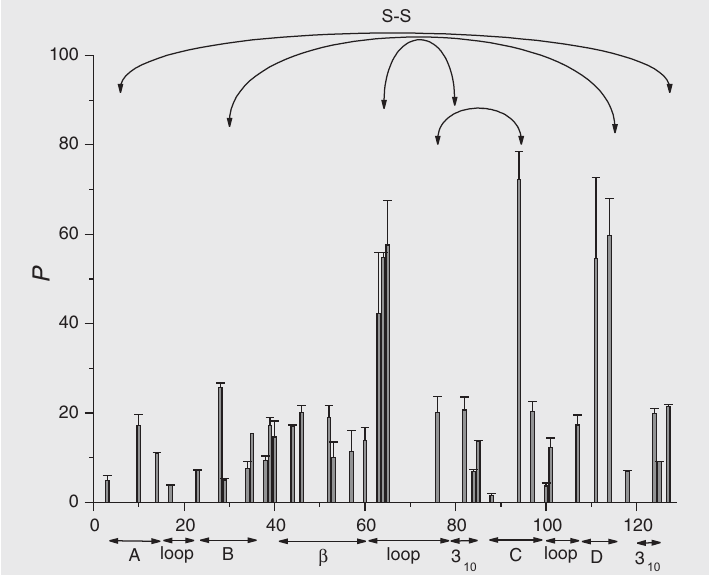
Figure 4. P -factors of the pressure-induced cold-denatured state of hen egg white lysozyme as a function of residue number (HEWL; 5% HEWL, 20 mM maleate buffer, pD 2.4, at -13 º C, and 3.75 kbar). Highest protection is found at or in the vicinity of the cross-linked cysteines C64, C94 and C115. On the average, the P -factors are about five times higher than those obtained under heat-denaturing conditions. For other explanations, see legend to Figure